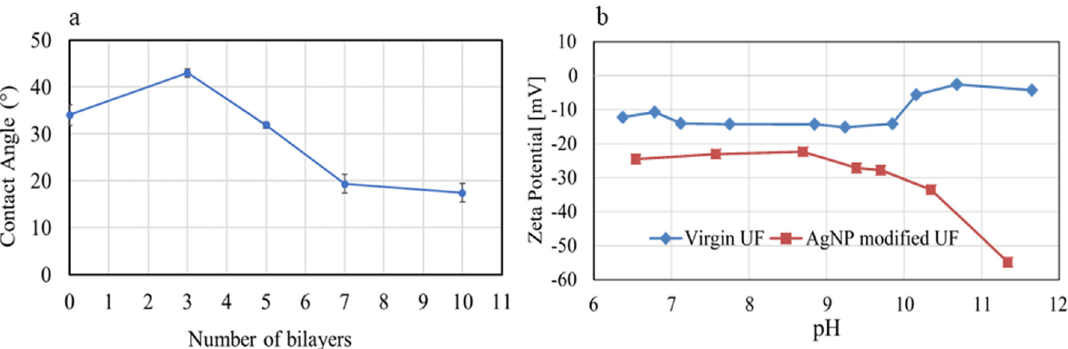
Figure 7. ( a ) Contact angles of virgin membrane (0 BL) and modified membranes as a function of the number of PAH / PAA BLs deposited (error bars represent standard deviation of 5 measurements); ( b ) Zeta potential of virgin and 5 AgPNP-BL membrane surfaces as a function of pH.